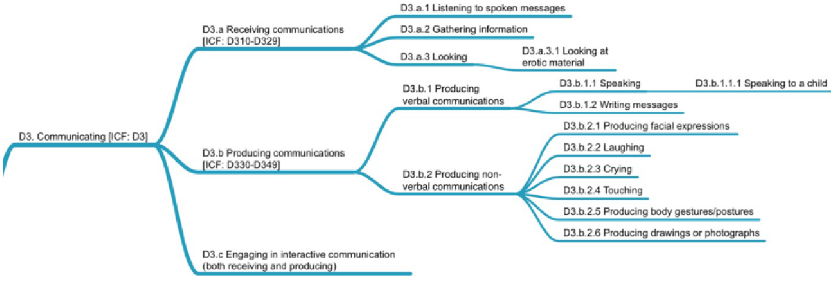
Fig 5. D3 domain on